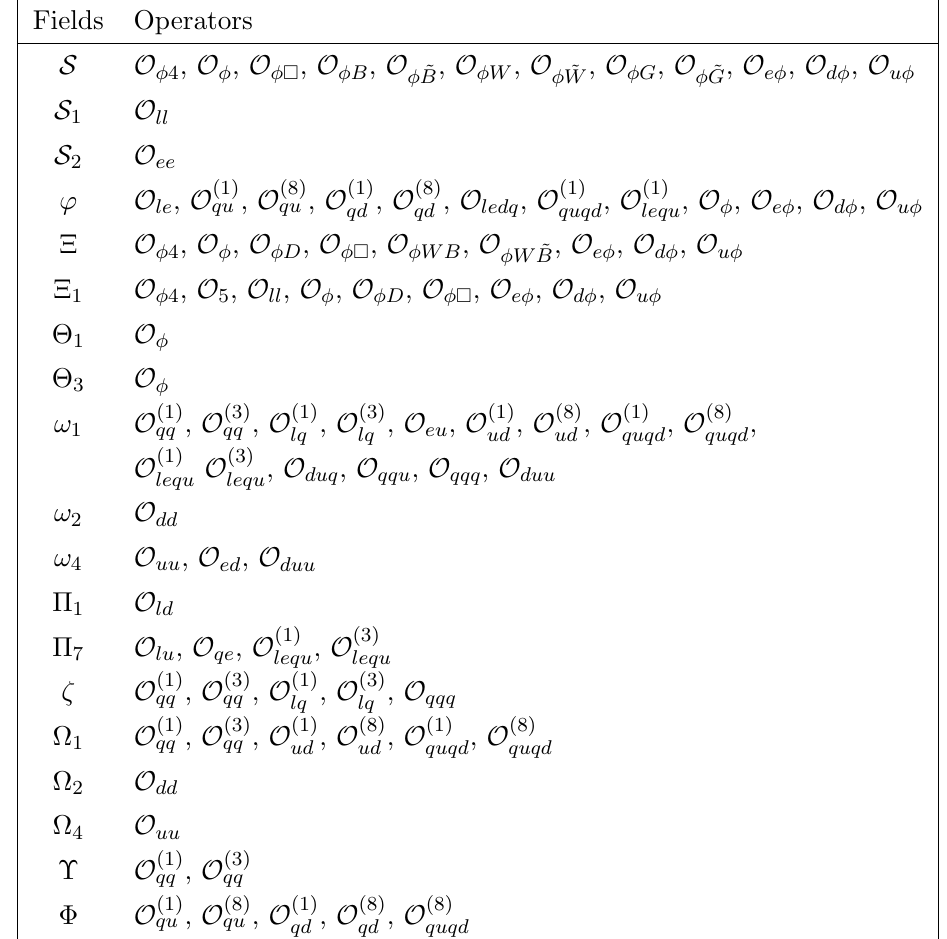
Table 7 . Operators generated by the heavy scalar (cid:12)elds introduced in table